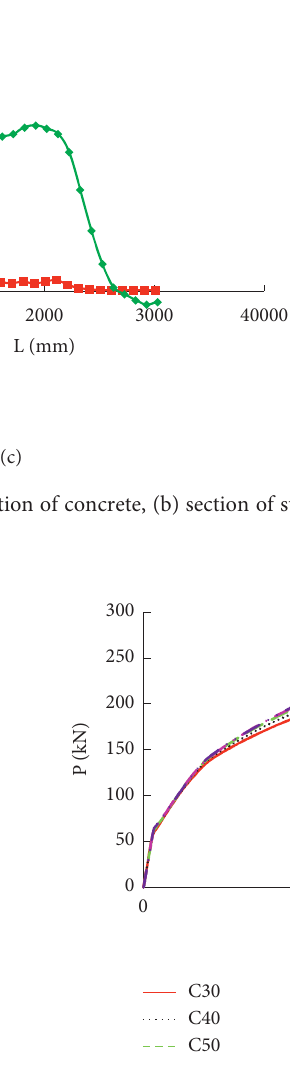
Figure 7: The load-deformation curve of different strength grades of